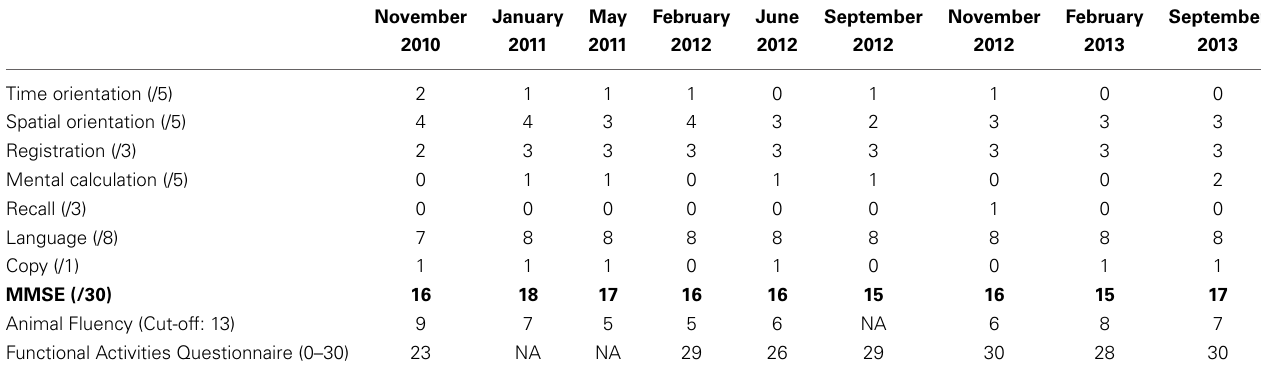
Table 4 | Longitudinal cognitive assessment of Mrs YCFZ, from November 2010–September 2013.